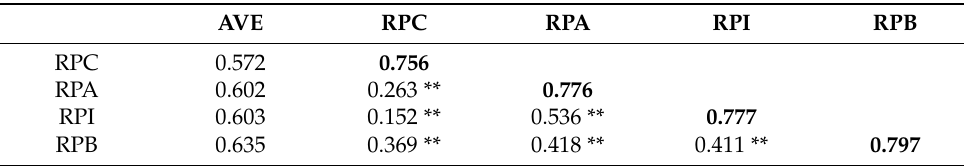
Table A5. Results of discriminant validity